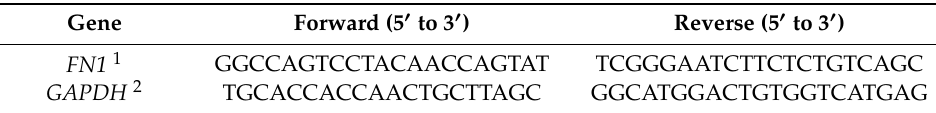
Table 1. Sequences of quantitative reverse transcription–polymerase chain reaction (qRT–PCR) primers. Gene Forward (5 (cid:48) to 3 (cid:48) ) Reverse (5 (cid:48) to 3 (cid:48)